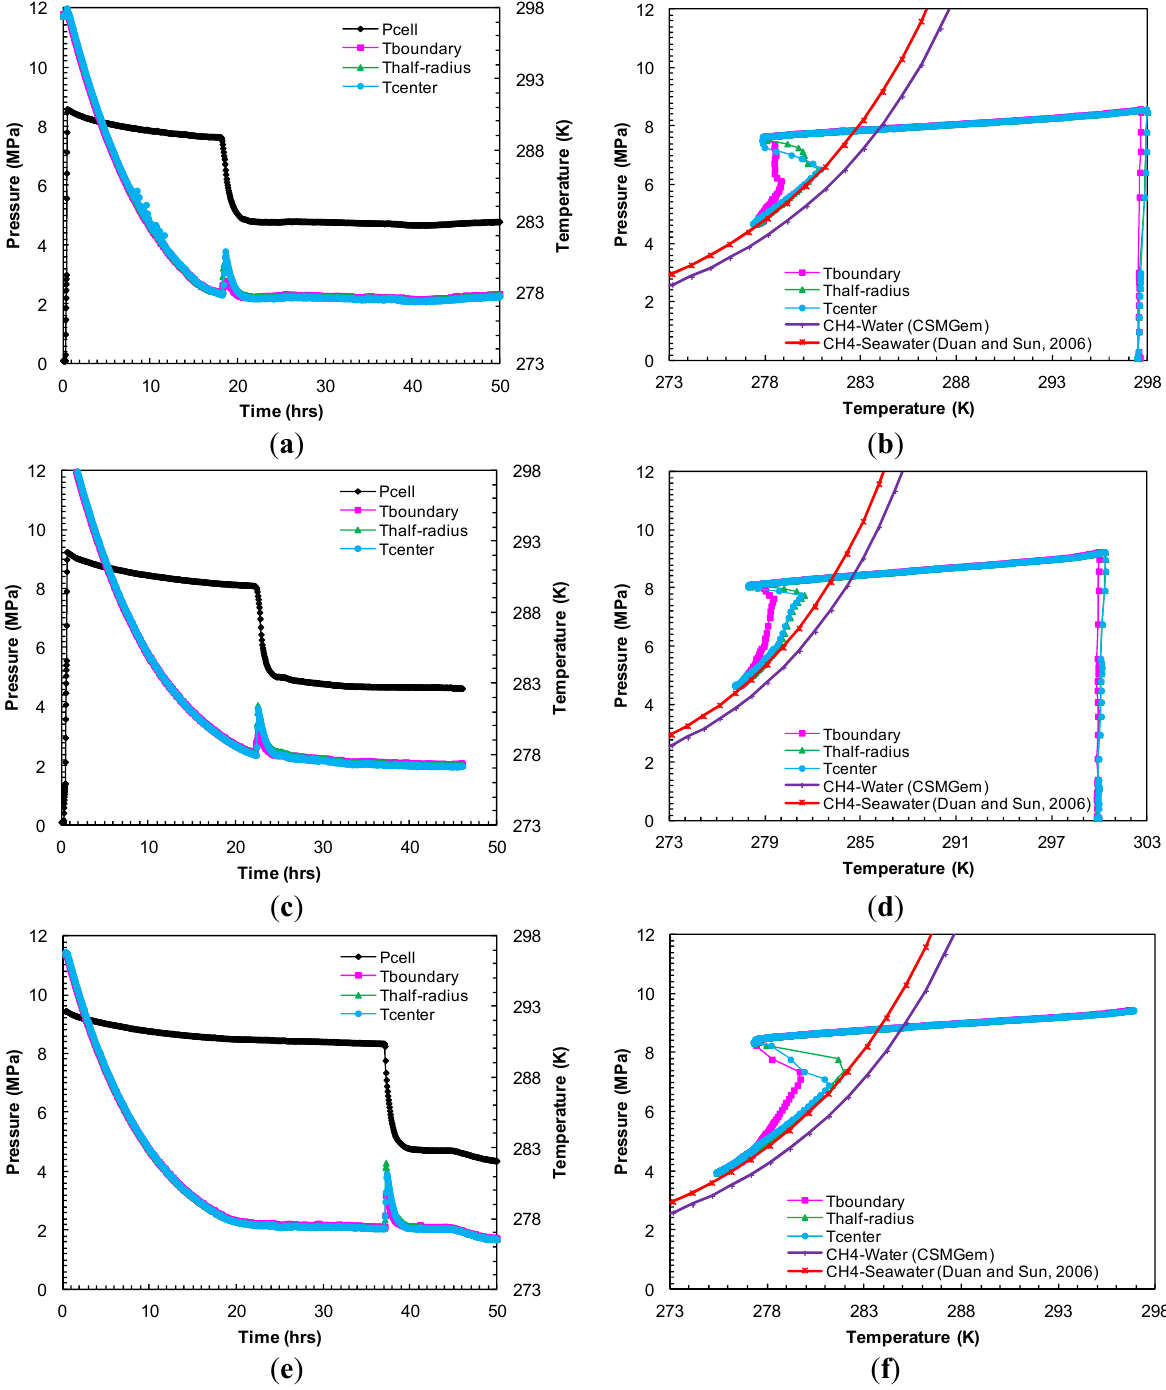
Figure 2. ( a , c , e ) Cell pressure/temperatures against time during methane charging and subsequent hydrate formation in Experiments 1–3; ( b , d , f ) Comparison of cell pressure against temperature within sand-pack during hydrate formation in Experiments 1–3 with the seawater-bulk methane hydrate stability